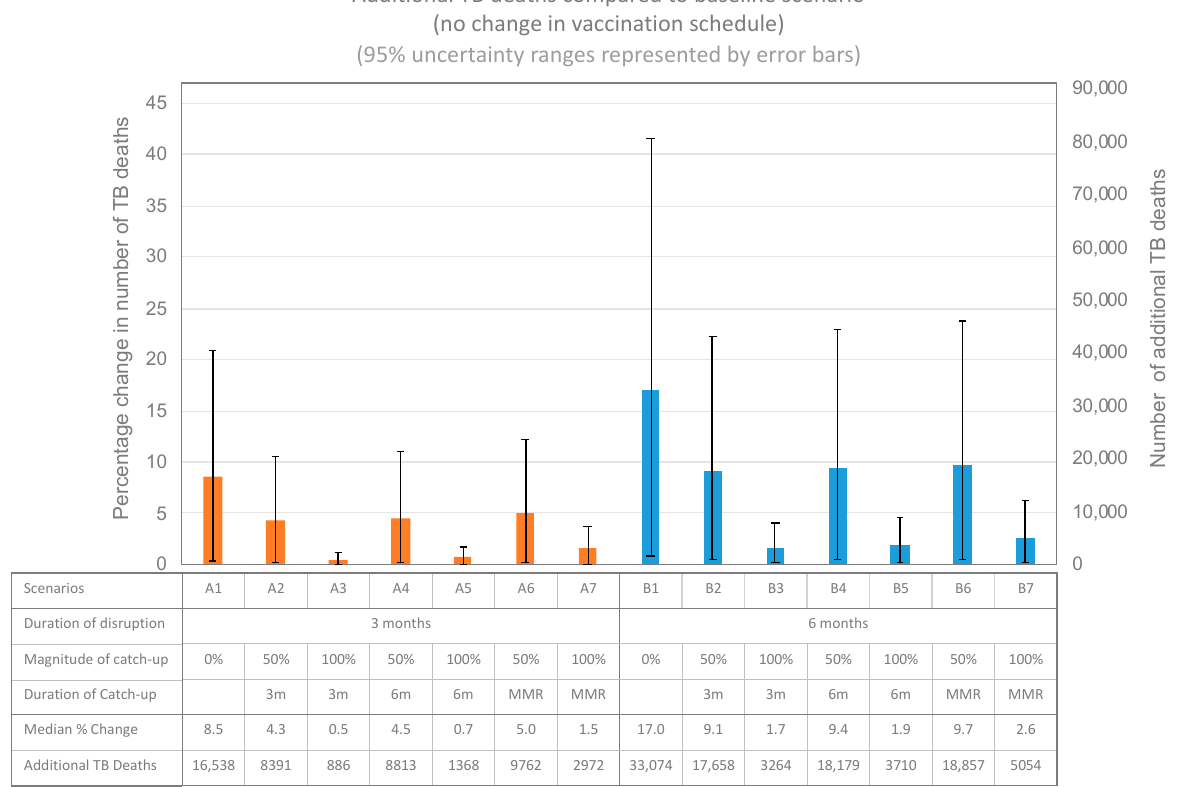
Figure 2. Additional paediatric tuberculosis (TB) deaths from 14 scenarios compared to a baseline of no